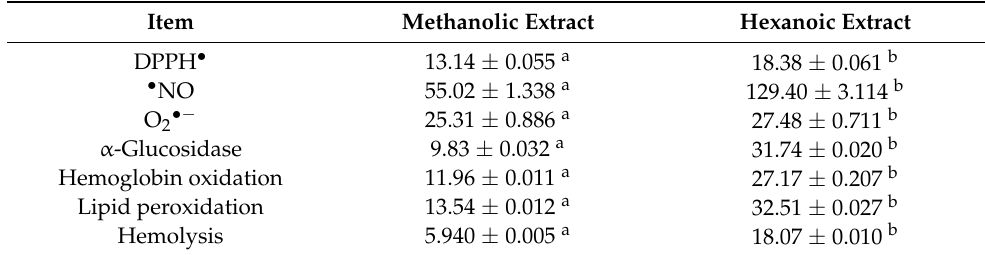
Table 3. IC 50 (mg/mL) values found in the antioxidant activity, α -glucosidase, hemoglobin oxidation, lipid peroxidation, and hemolysis assays for S. androgynus leaves.